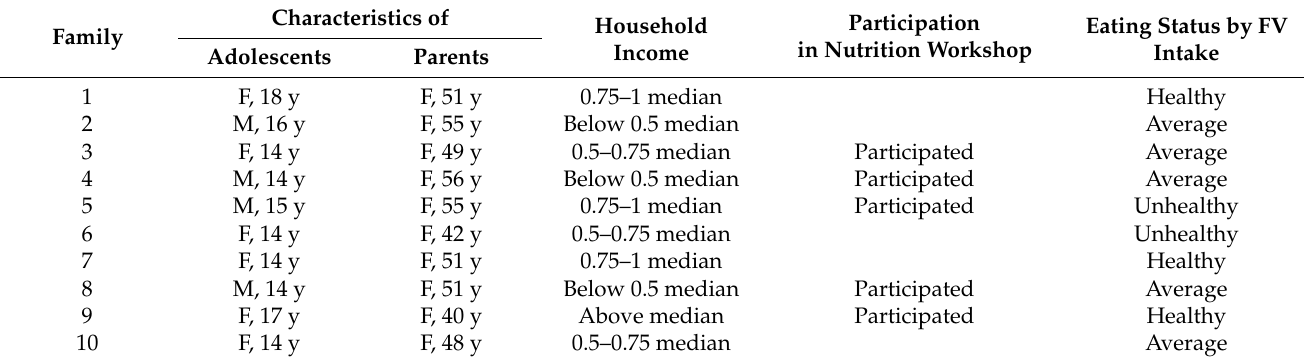
Table 2. Characteristics of parent–adolescent dyads by